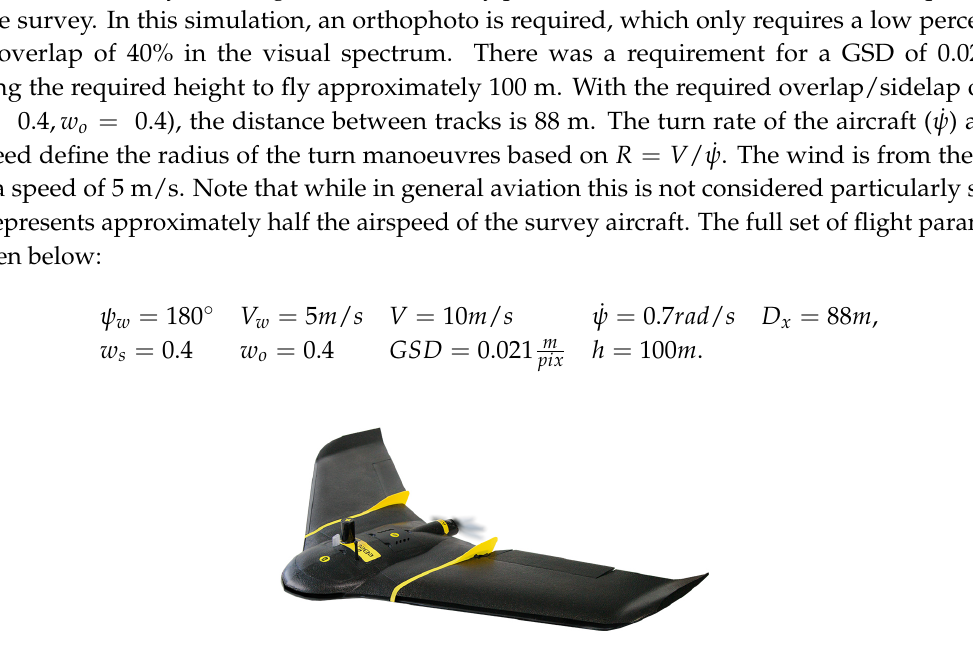
Figure 18. eBee example survey aircraft